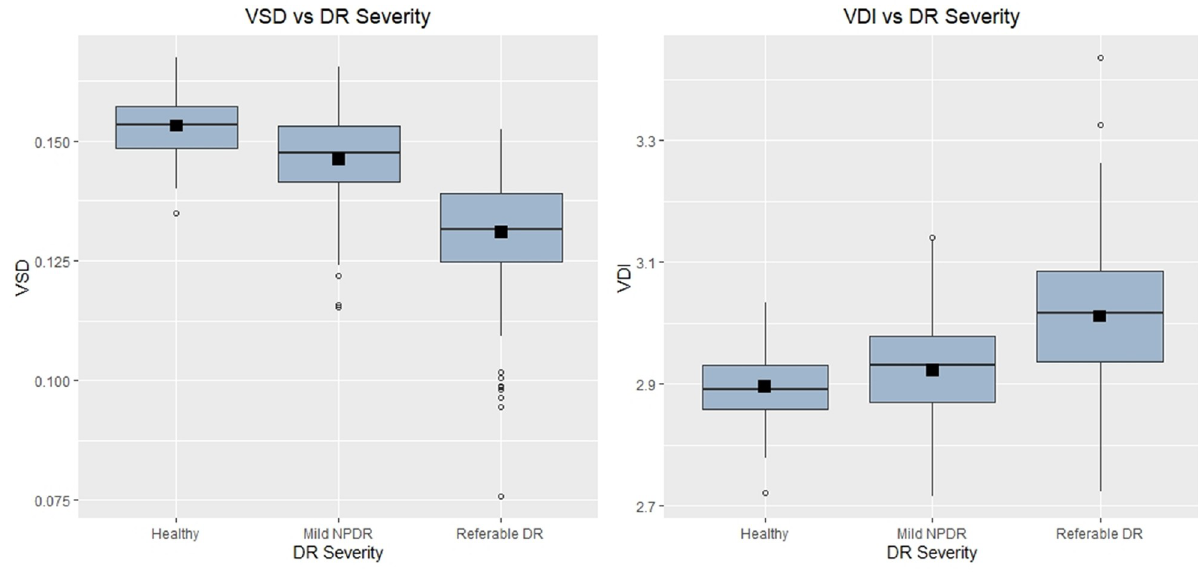
Fig 1. Box and whisker plots of the VSD and VDI distribution in the tertiary referral centers (Cohort 1). Start and end of boxes represent 25 th and 75 th quartiles respectively. Vertical lines extend to the smallest and largest values no further than 1.5 times the interquartile range. The middle horizontal line represents the median and the black square box represents the mean. Outliers are plotted as circles.